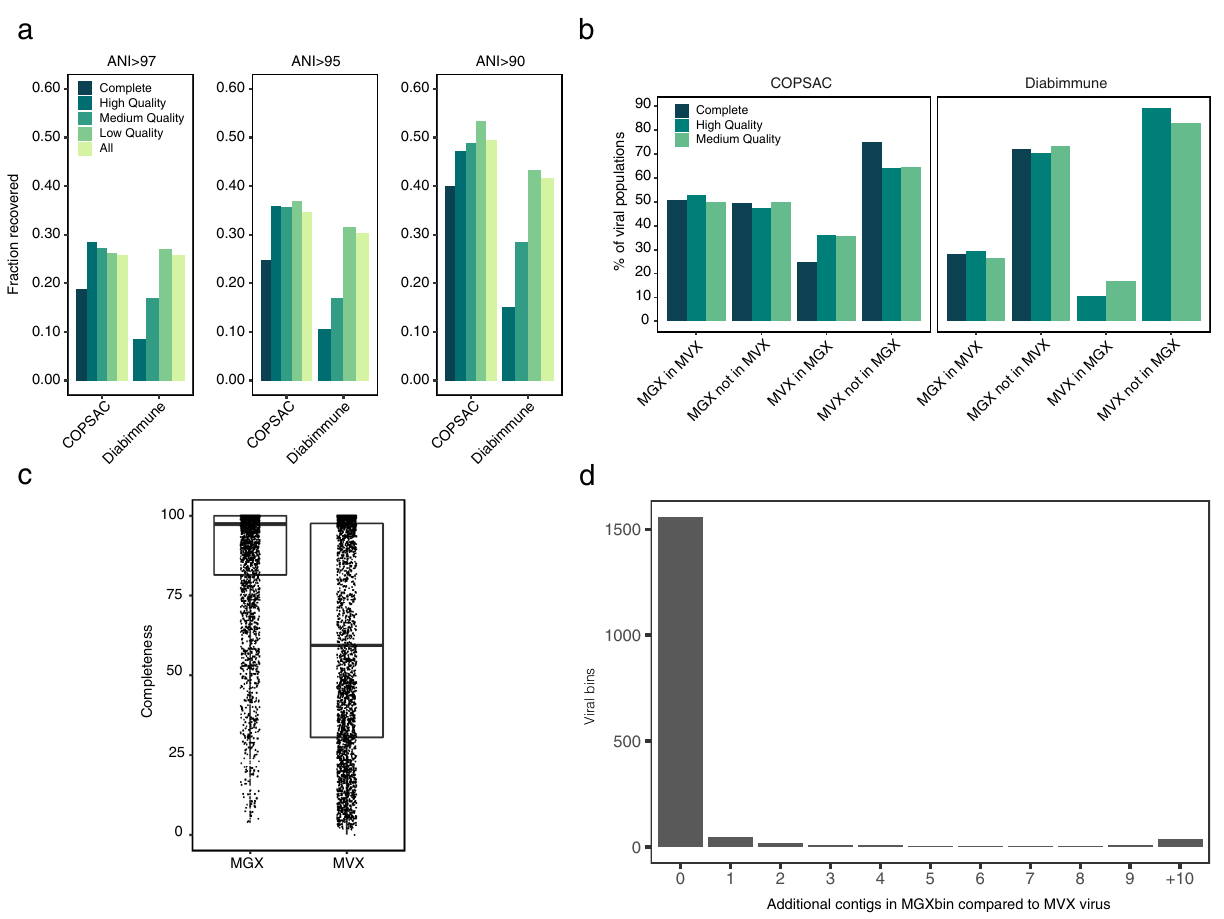
Fig. 2 Binning the metagenome identi fi es viral genomes not identi fi ed from the metavirome. a The fraction of metavirome viruses in COPSAC and Diabimmune coloured at different levels of completeness or all together determined with CheckV, identi fi ed in VAMB bins from bulk metagenomics of the same cohorts. We de fi ned a metavirome virus to be recovered if the aligned fraction was at least 75% and ANI was >90, >95 or >97.5 to a VAMB bin based on FastANI. b The percentage of viral populations, at different levels of completeness determined with CheckV, identi fi ed in both metaviromes (MVX) and bulk metagenomics (MGX) or unique to either dataset. Shared populations are identi fi ed with a minimum sequence coverage of 75% and ANI above 95%. (1) MGX in MVX: % of Viral populations found in MGX also found in MVX. (2) MGX not in MVX: % of Viral populations unique to MGX i.e. not found in MVX. (3) MVX in MGX: % of Viral populations found in MVX are also found in MGX. (4) MVX not in MGX: % of Viral populations unique to MVX i.e. not found in MGX. c Viral genome completeness estimated for n = 2646 viruses found both in metaviromes and bulk metagenomics sharing the same nearest reference in the CheckV database. d The number of contigs in viral bins from bulk metagenomics that do not align to the closest viral reference in the metavirome. In the majority of viral bins, all contigs align to the nearest reference. ANI average nucleotide